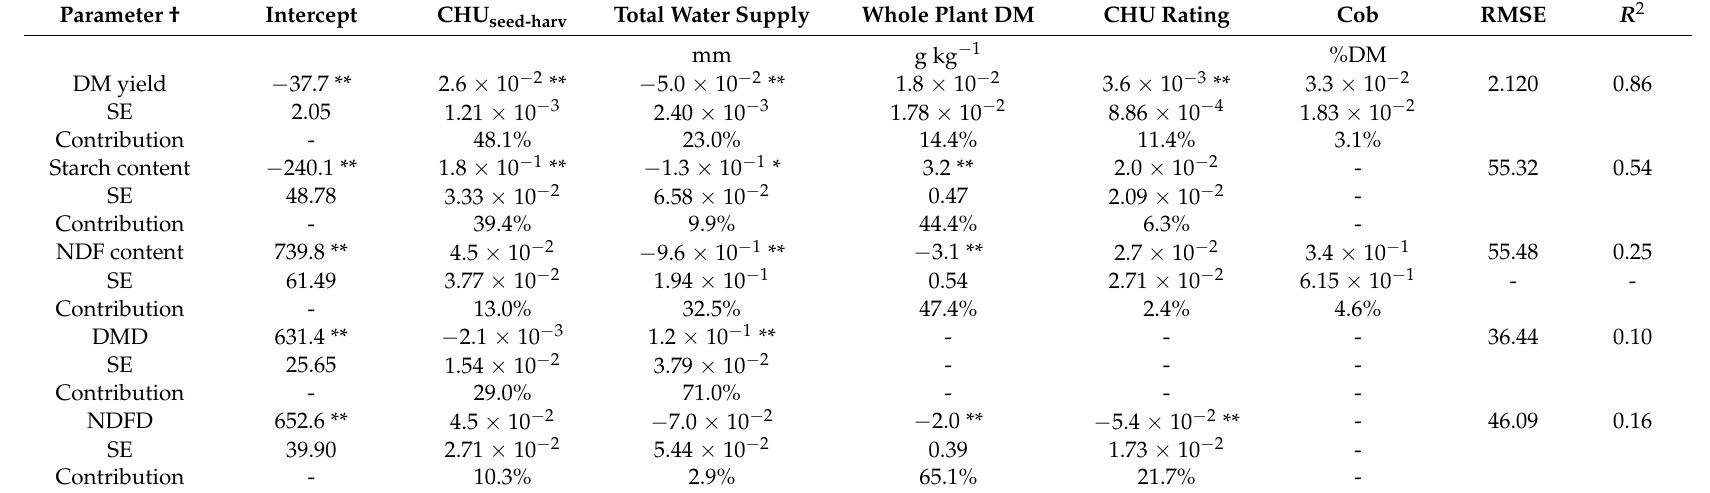
Table 11. Prediction equations of nutrients (g kg − 1 ) and yield (Mg ha − 1 ) of corn grown for silage based on indicators directly measurable in the